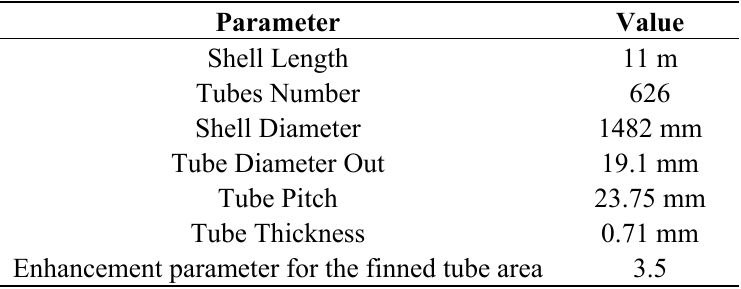
Table 4. Geometrical features of the primary heat exchanger.